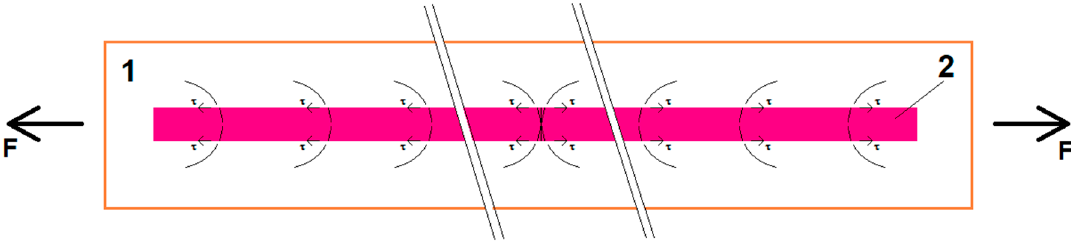
Figure 8. Nanowires as a continuous reinforcing element receiving the load from the matrix through tangential stresses; τ : 1—matrix (cured resin), and 2—nanowire connected to the matrix.